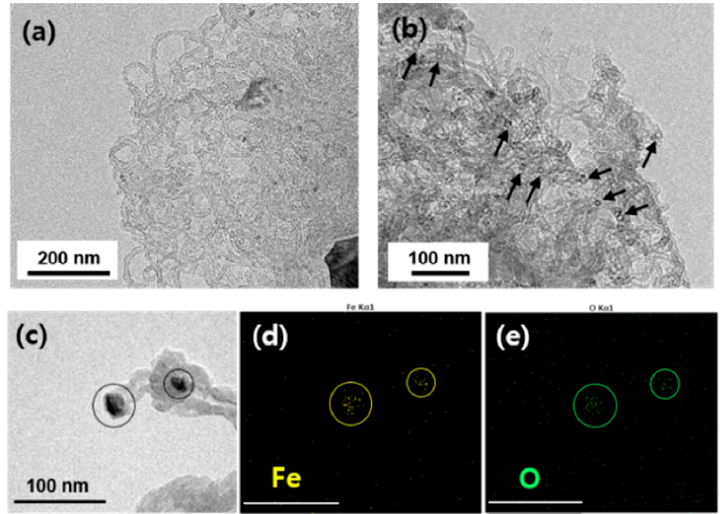
Figure 8. TEM images showing CNTs grown on Al 2 O 3 at 650 °C for 10 min with 10 rpm of RCVD chamber. ( a ) A representative and ( b ) magnified images. Arrows in ( b ) indicate cross-sectional views of individual CNT. ( c ) A bright field TEM image of CNT. Corresponding EDS mapping results for ( d ) iron and ( e ) oxygen, respectively. Scale bars in ( d ) and ( e ) are 100 nm.